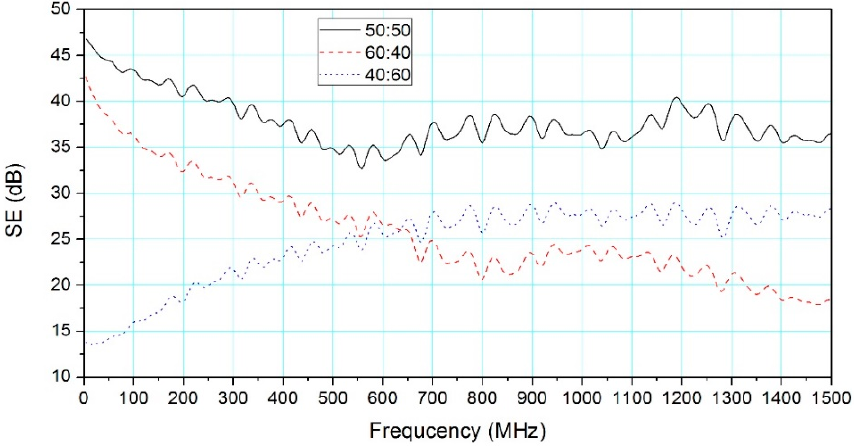
Figure 5. Effect of wood/resin ratio on SE (carbonization temperature of 1000 °C, apparent density of 0.639 g/cm 3 (50:50), 0.625 g/cm 3 (60:40) and 0.642 g/cm 3 (40:60), respectively).